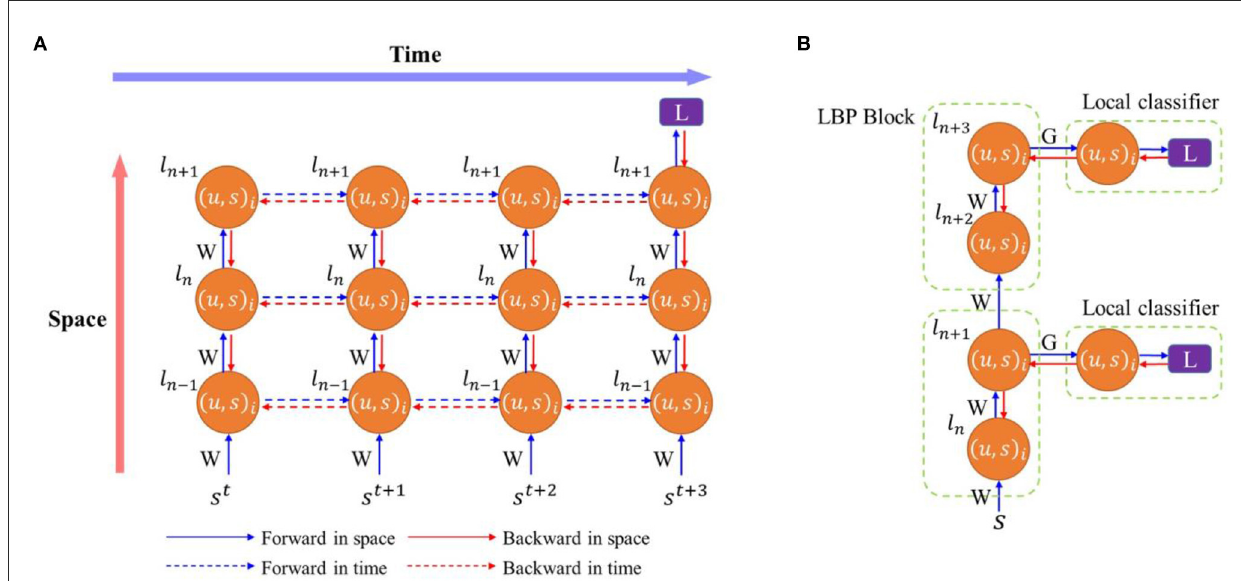
FIGURE1 (A) Training SNNs with backpropagation through time. Training processes are unfolded in time. (B) Training SNNs with local backpropagation. Each node represents a spiking neuron layer where l is the layer index, i is the neuron index, u is the membrane potential, and s is the spike. W is weights between layers in the main network and G is the weights between a network layer and a local classifier. L is a loss function.